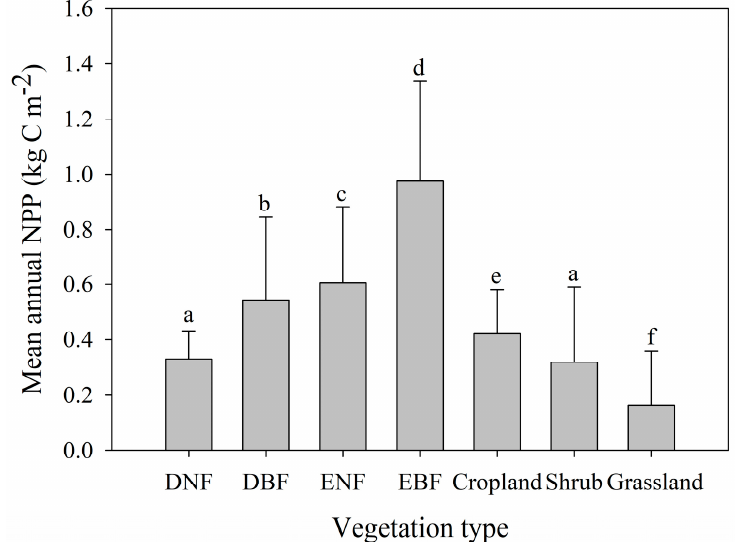
Figure 3. Mean annual Net Primary Productivity (NPP) for each vegetation type over 2001–2014. The error bar in each column indicates the standard deviation. Different lowercase letters indicate significant differences in NPP among vegetation types (one-way ANOVA and t -test, p < 0.001).